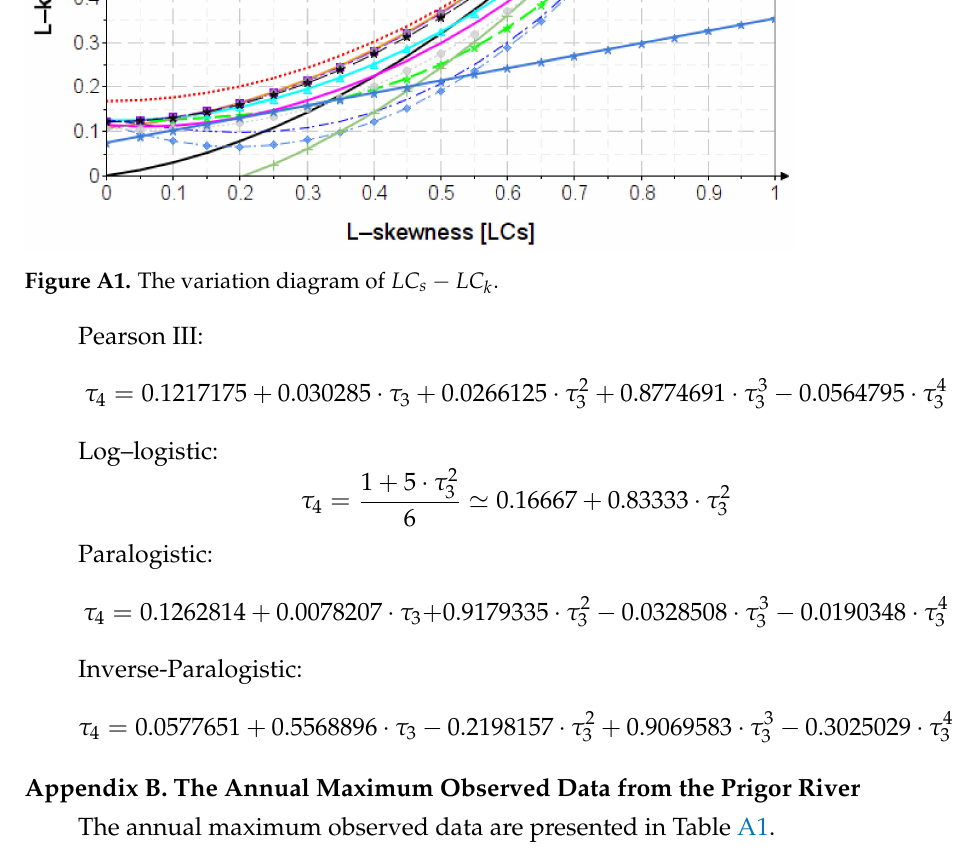
Table A1. The observed data from the Prigor hydrometric station. Annual Maximum